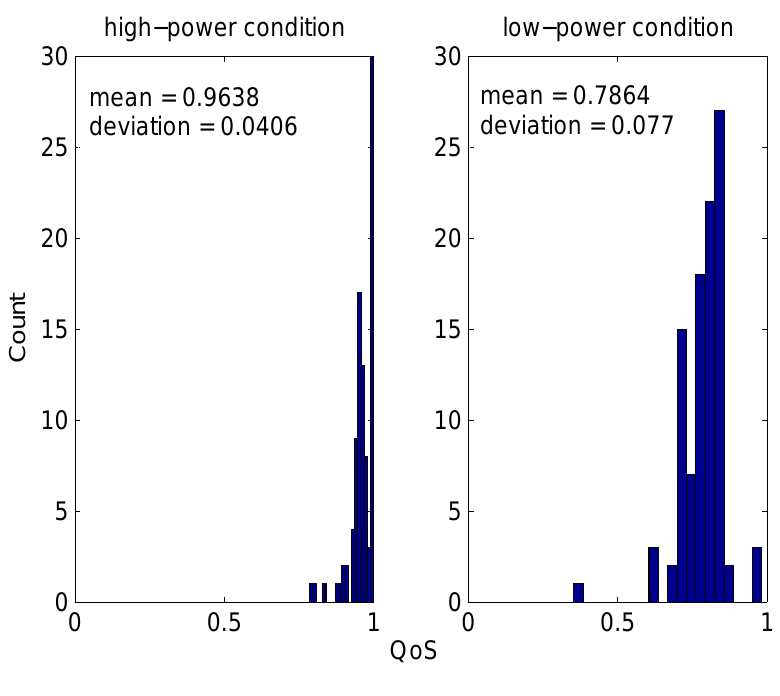
Figure 19. Histogram of the QoS performance under the quality of service-oriented policy for ( left ) high and ( right ) low power storage levels.